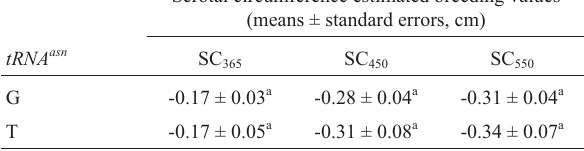
Table 4 - Analysis of variance between scrotal circumference (SC, in cen- timeters) estimated breeding values for the G5501 → T (G, n = 247; T, n = 71) mitochondrial tRNA asn single nucleotide polymorphism (SNP). The table shows degrees of freedom (DF) and the mean square SC esti- mated breeding values at 365, 455 and 550 days.